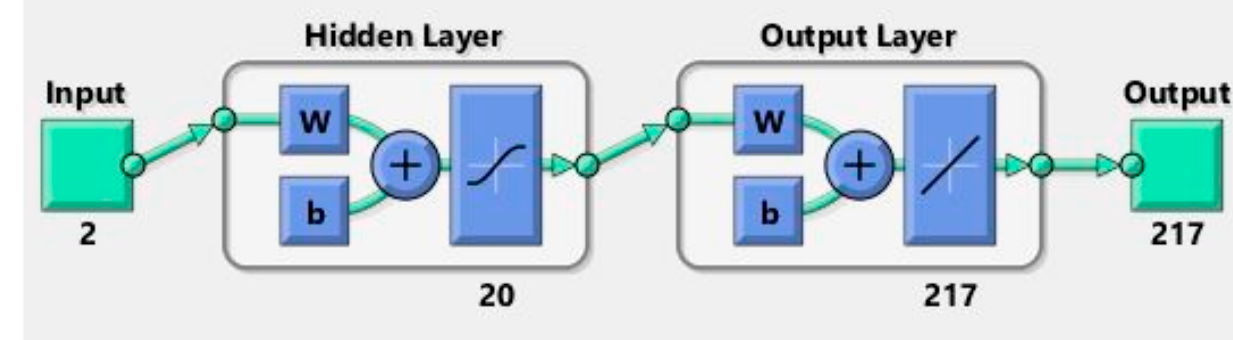
18 of 30 Figure 13. ANN sensitivity of the different models designed for the training type: ( a ) BR, ( b ) LM, and ( c ) SCG. It has been observed that, in all models, when the MSE decreases, the R 2 increases. Furthermore, the MSE decreases as the number of divisions performed in the output data